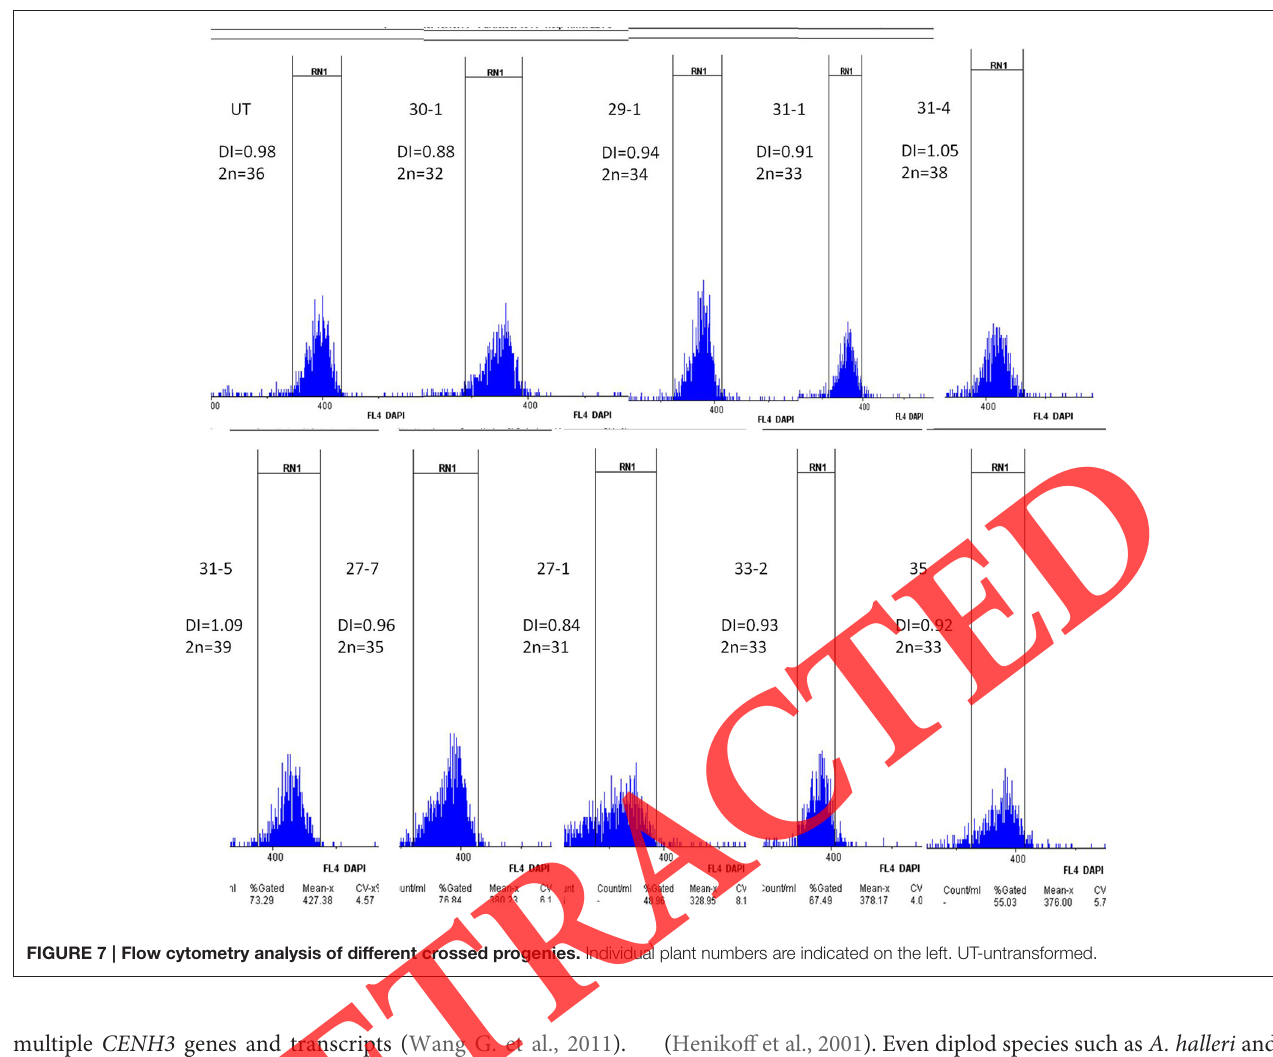
multiple CENH3 genes and transcripts (Wang G. et al.,